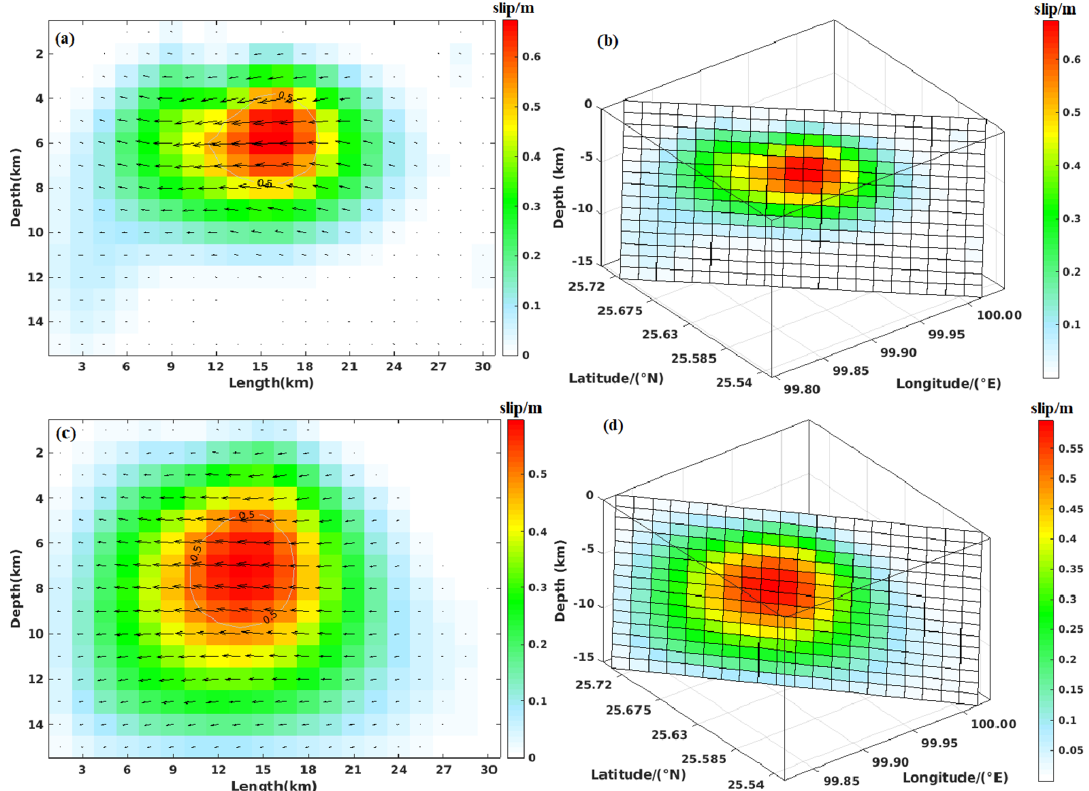
Figure 7. Different fault slip distribution models from two InSAR deformation datasets: ( a , b ) are two–dimensional (2D) and three–dimensional (3D) displays of fault slip distribution inverted based on deformation results extracted by time–series InSAR, respectively; ( c , d ) are 2D and 3D displays of fault slip distribution based on deformation results extracted from a single interferogram, respectively; the arrow indicates the movement direction of each sub–fault plane.